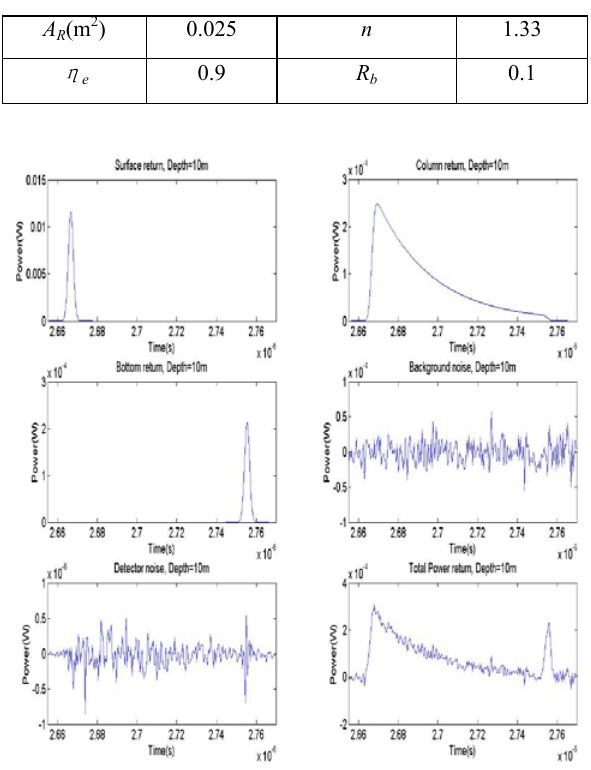
Fig.1 Simulated returned waveforms of hydrographic LiDAR with wavelength 532nm. The water is of Case II quality (the average concentration of phytoplankton 3 sediment 2.6mg / l S = )